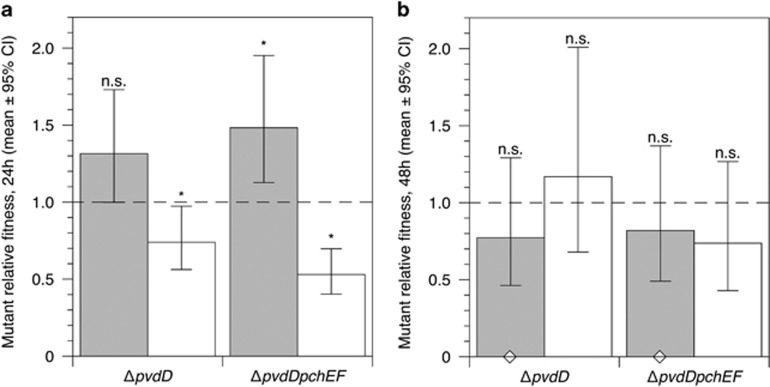
Relative fitness of ΔpvdD and ΔpvdDΔpchEF mutants in pure culture (grey bars) and in mixed culture with an isogenic wild type (white bars) in SWF after (a) 24 and (b) 48 h of growth. Bars show means of 10 replicates split across two replica experiments, with associated 95% confidence interval. Twenty-four hour fitnss was detemrined only by the presence/absnece of the wild type (ANOVA eliminating experimental block: genotype F1,35=0.621, P=0.436; presence/absence of wild type: F1,35=35.2, P<0.001; interaction term: F1,35=2.82, P=0.102); The ΔpvdD mutant’s relative fitness was not significantly different from 1 in pure culture (post hoc t-test, P=0.051), and the ΔpvdDΔpchEF mutant slightly and significantly >1 (P=0.006), but both were less fit than the wild type in mixed culture (P=0.032 and <0.001, respectively). Forty-eight-hour fitness was not affected by genotype or co-culture (ANOVA eliminating experimental block: genotype: F1,35=0.045, P=0.833; presence/absence of wild type: F1,35=1.34, P=0.255; interaction term: F1,35=0.078, P=0.781): both mutants had a relative fitness of 1 regardless of wild type presence (post hoc t-tests, P⩾0.104). In both panels, results of post hoc tests for relative fitness=1 are shown with *=P<0.02; n.s.=not significant. Confidence intervals and P-values in (b) are taken from a model that excluded two outliers where relative fitness was zero (indicated by open diamonds): including these outliers in the analysis did not change any of the conclusions given in the text.